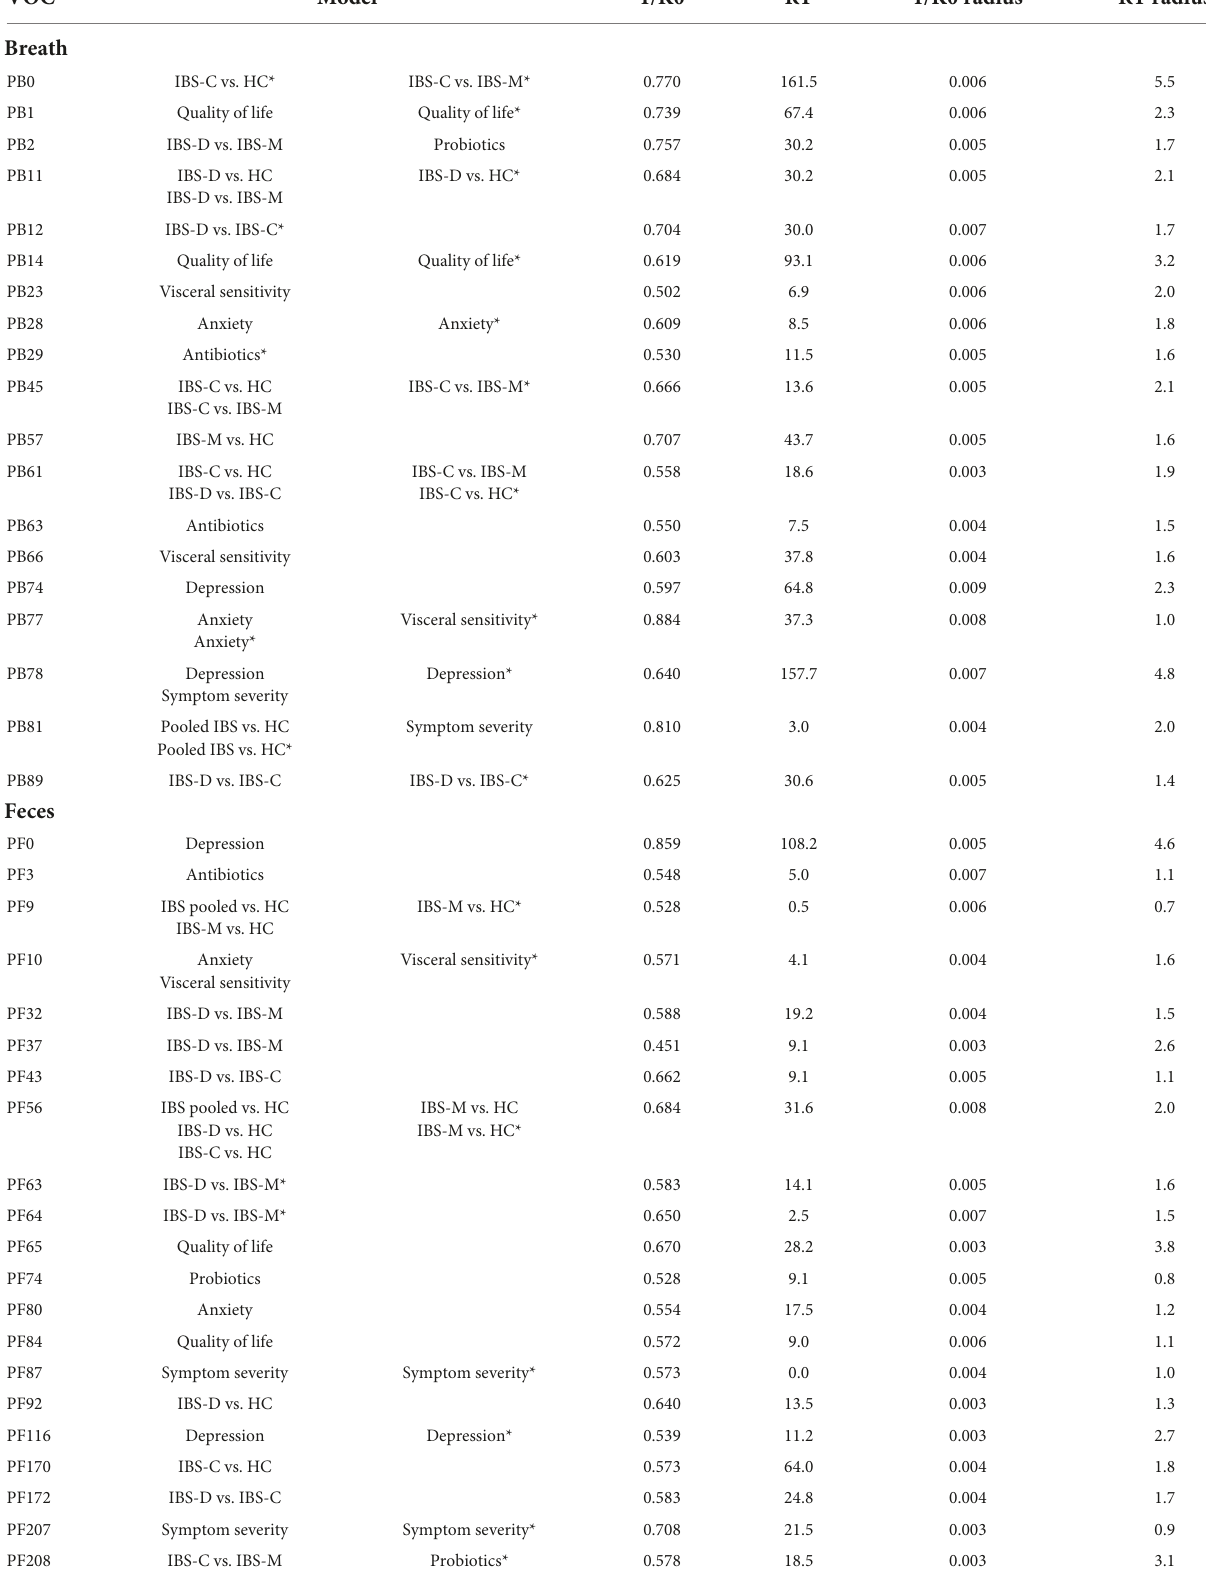
TABLE 4 Characteristics VOCs used in logistic regression